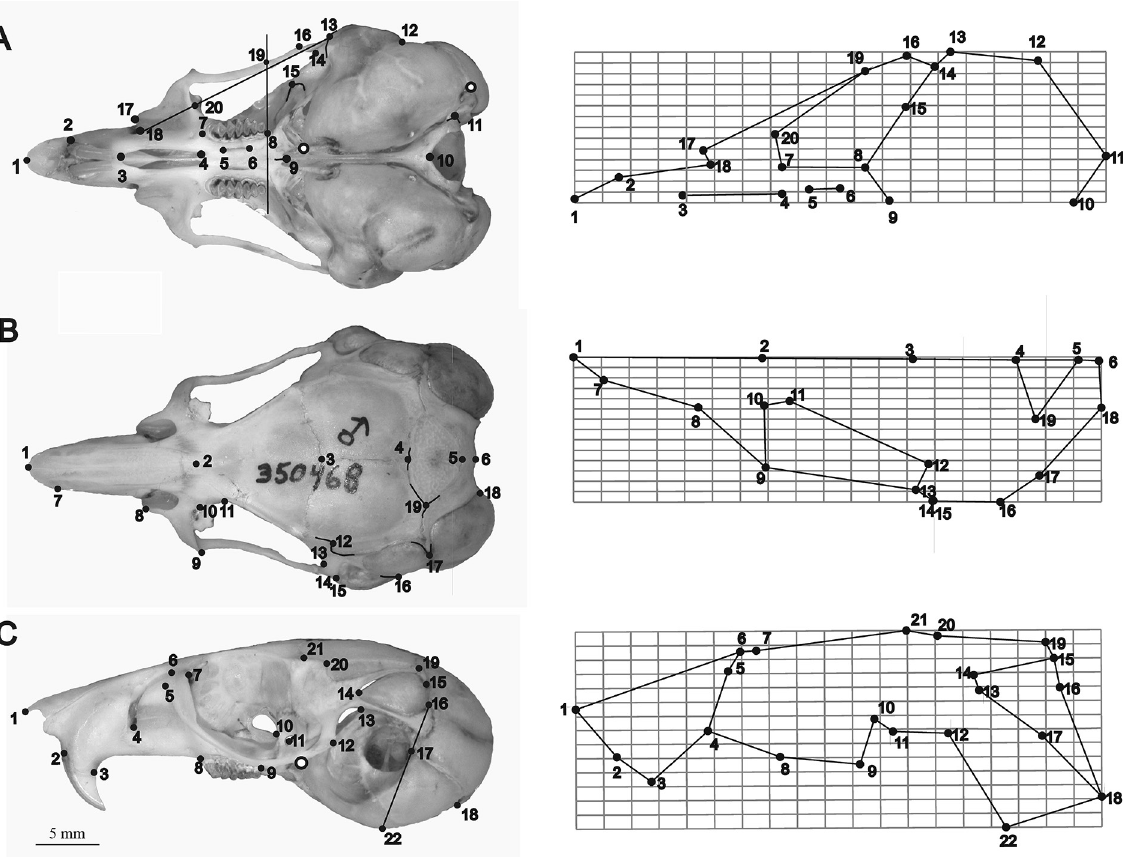
Fig. 2. Landmarks positioned on the cranium of Meriones crassus Sundevall, 1842 shown in (A) ventral (B) dorsal and (C) lateral views. The straight lines on the ventral and lateral views were used for defining semi-landmarks based on two other landmarks. Open circles on the ventral side: the most rostral and on the most caudal point of the tympanic bulla, and on the lateral side: the most rostral margin of the tympanic bulla. Short lines are drawn to highlight sutures which are unclear here and on which the landmarks have been